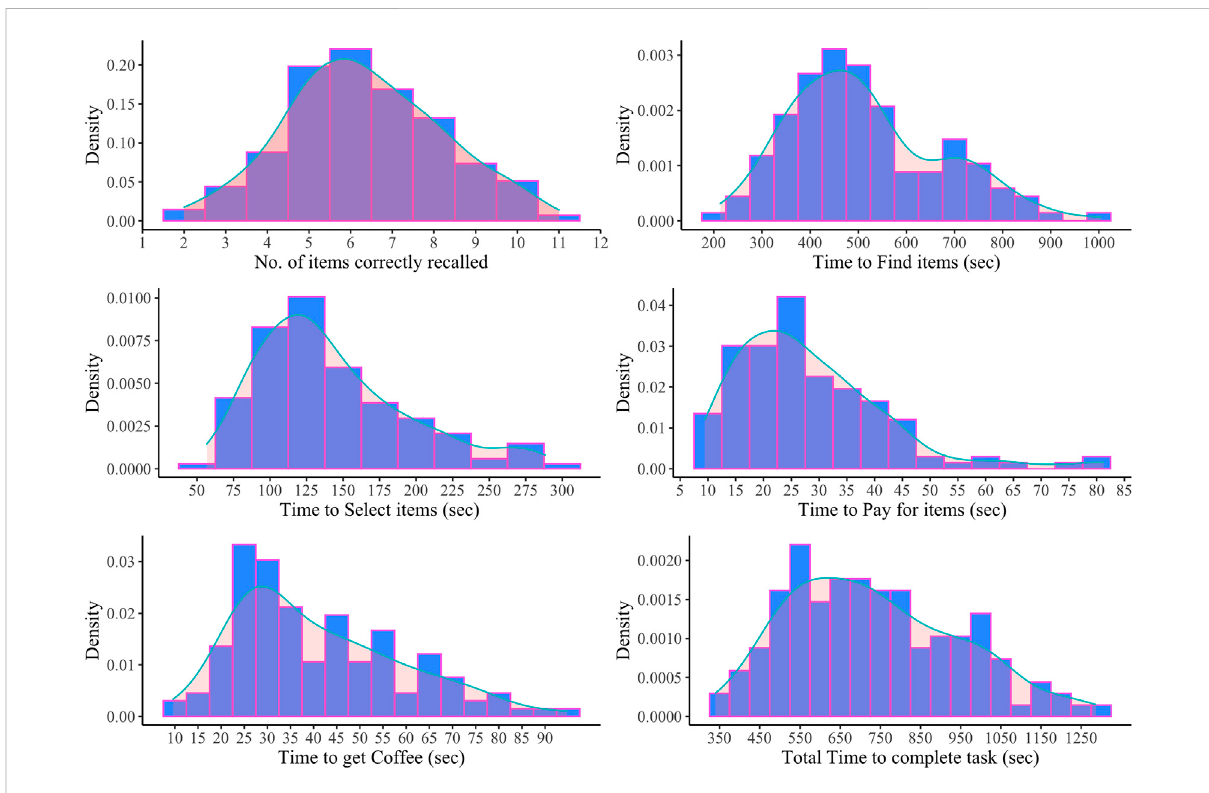
Figure 7. The Shapiro – Wilk test is a test of normality indicated that VStore Find deviated signi fi cantly from the normal